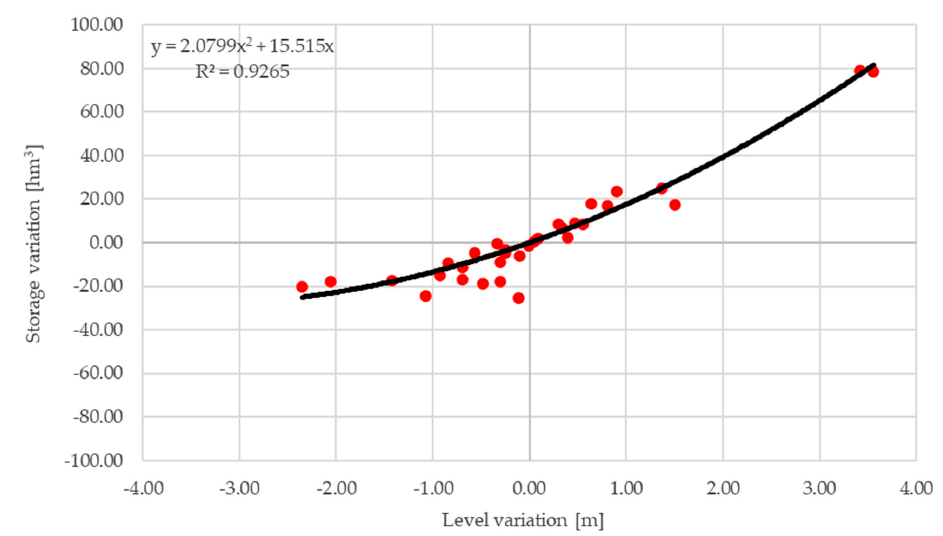
Figure 9. Scatter plot of level–storage variation pairs.